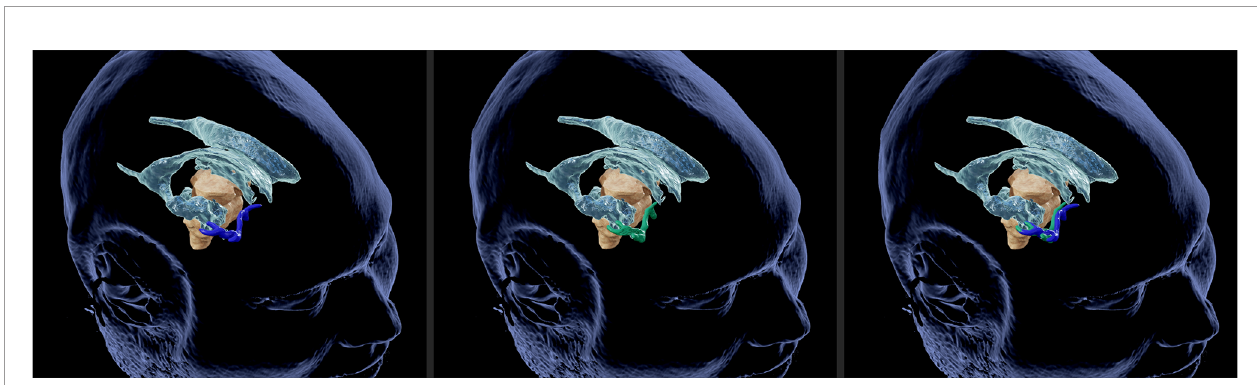
FIGURE 2 | Illustrative case no. 2. 3D view of vascular landmarks segmented in MRI (left) and US (middle). Combined presentation of both segmentations (right) depicts the spatial